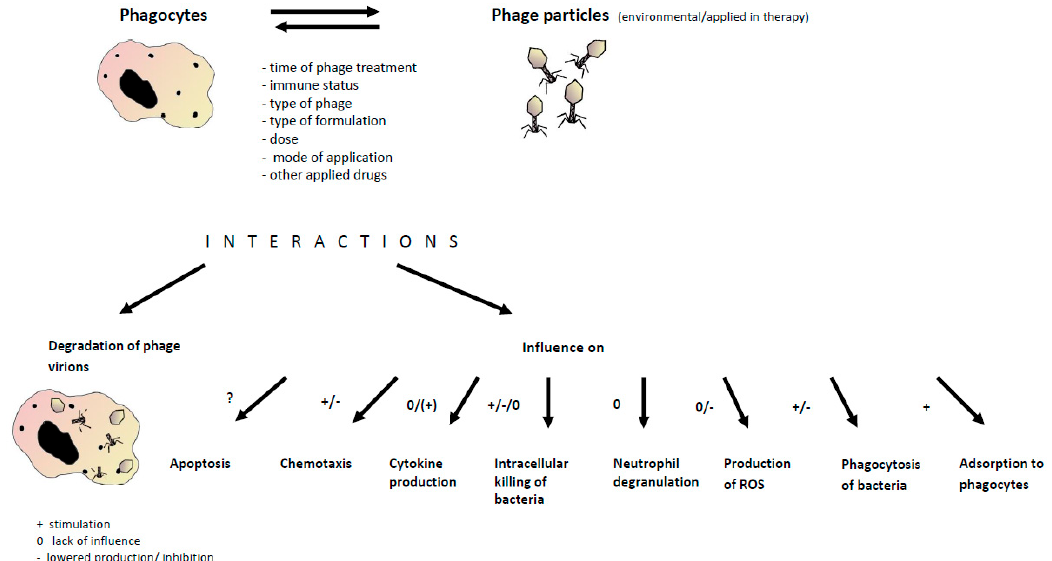
Figure 1. Summary of interactions between phages and phagocytes and possible implications for phage application in therapy. These interactions may be mediated by phages present in our environment and administered during phage therapy, and depend on a variety of factors (e.g., time of phage treatment, etc., as shown). As a result, various phagocyte functions may be affected which can have practical implications for the effectiveness of phage therapy.